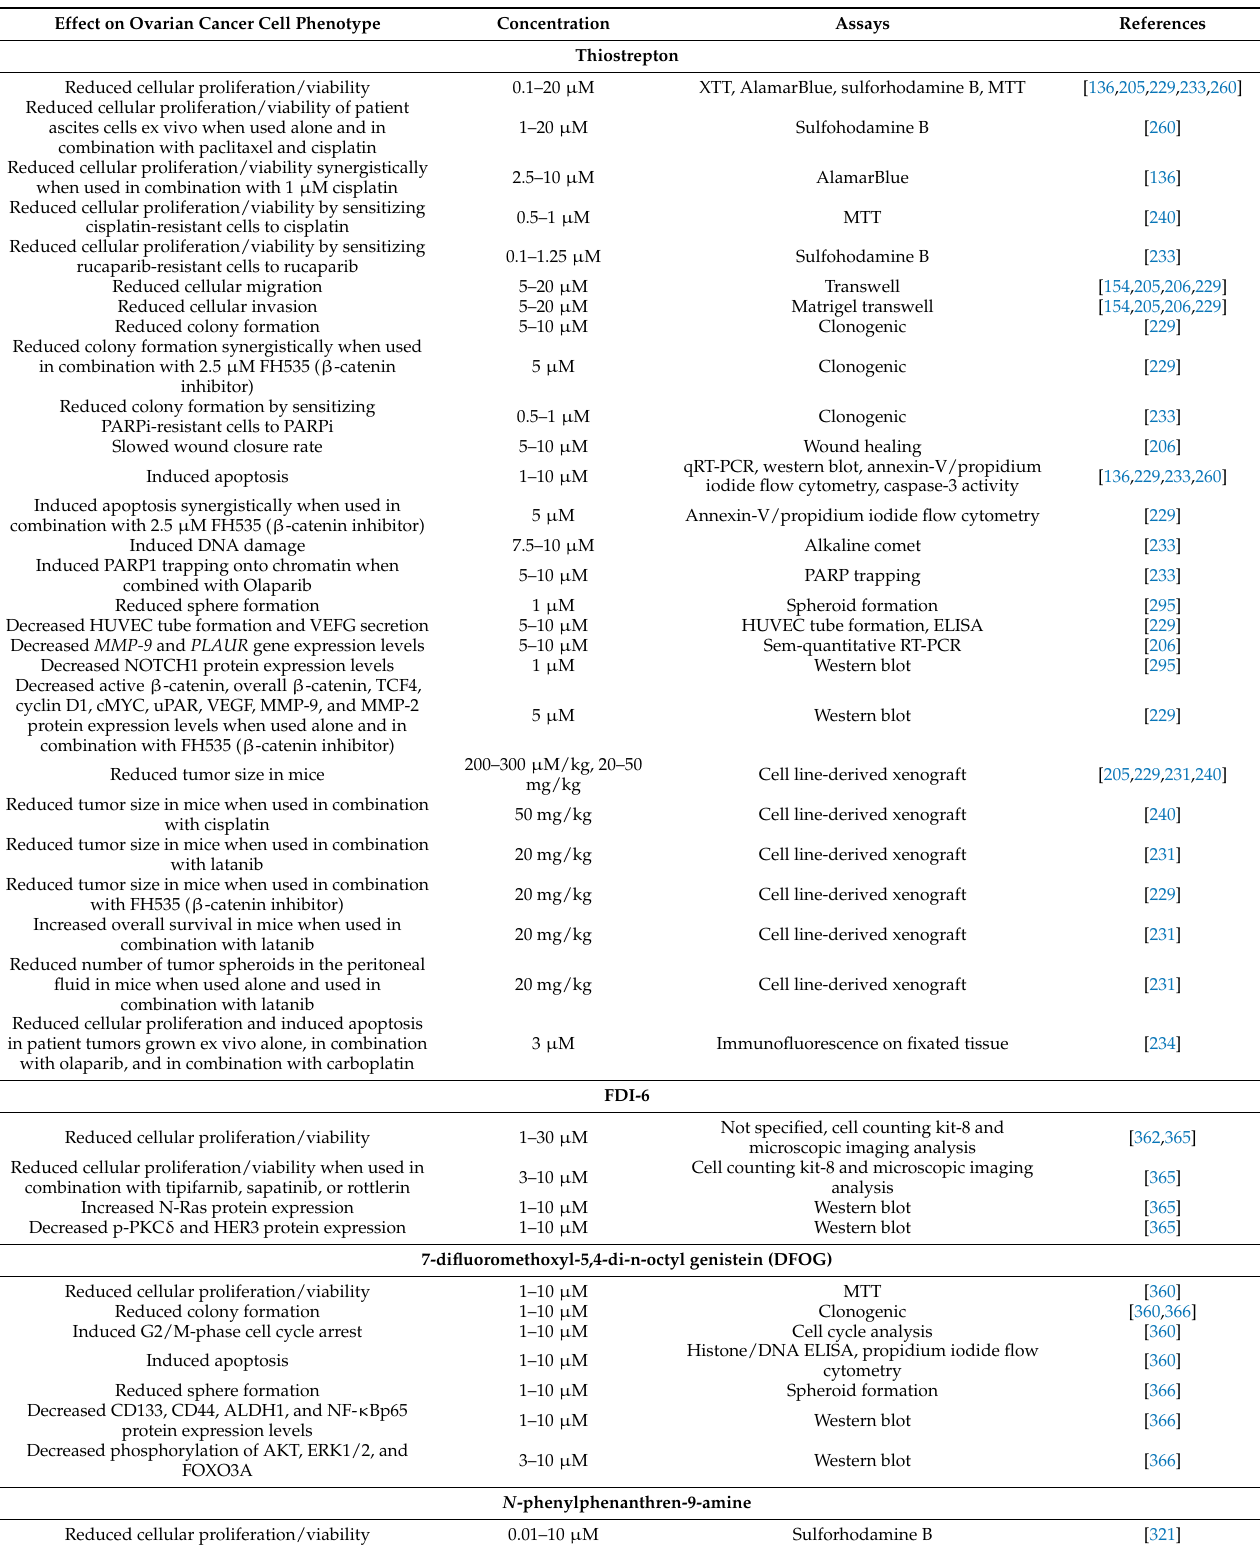
Table 3. FOXM1 inhibitors and their effects on ovarian cancer